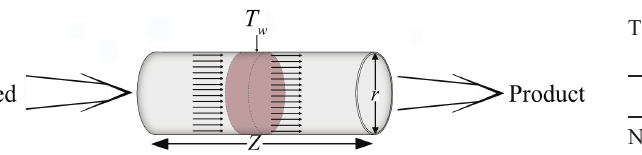
Fig. 1 – Reformer tube schematic